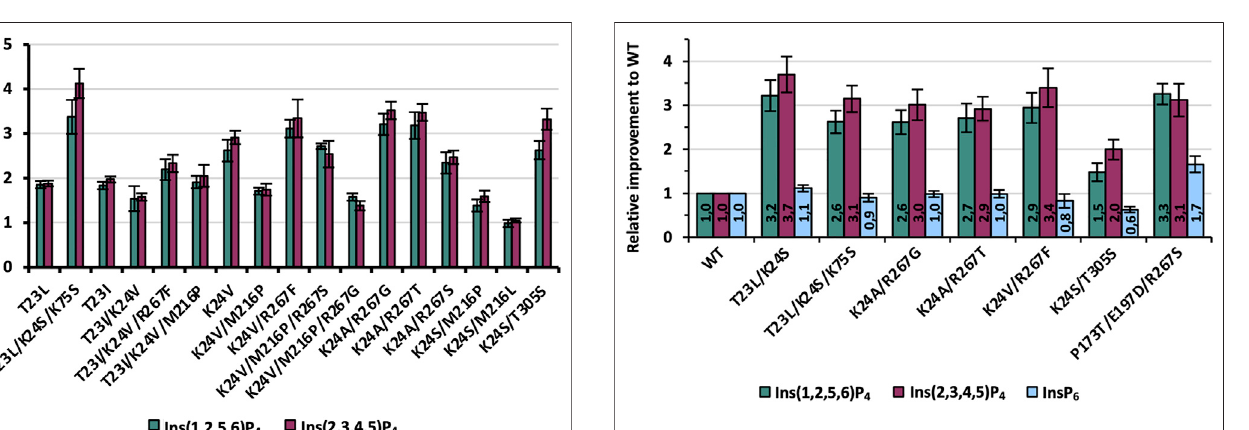
FIGURE 8 | Final improvements of the seven best variants identi fi ed during one round of KnowVolution. All enzymes are puri fi ed, and activity improvements weremeasured inmicrotiter plate(MTP) and calculated fromat least six independent